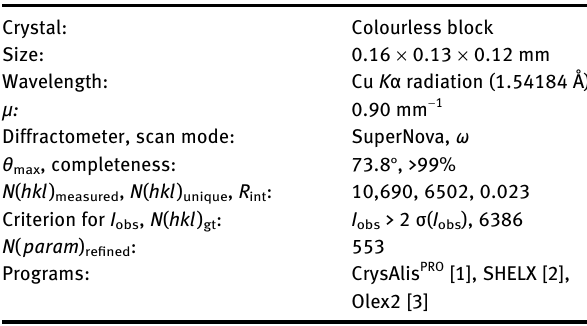
Table 1 contains crystallographic data and Table 2 contains the list of the atoms including atomic coordinates